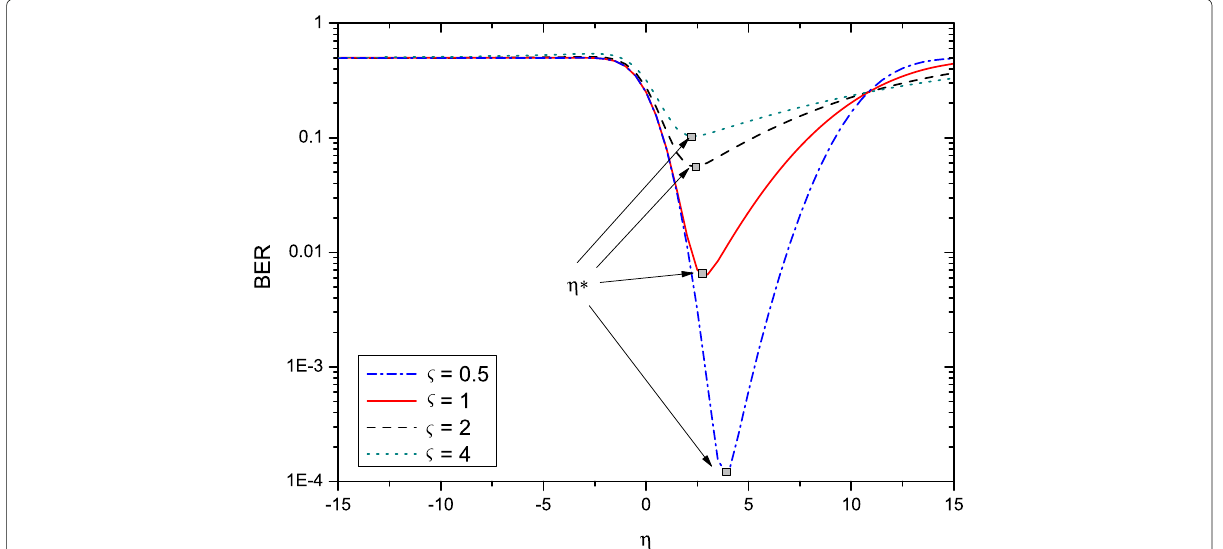
Fig. 3 The value of BER versus η with different ς when r = 0.9, ( a , b , c ) = ( 2 m,2 m,1.5 m ) , ( u , v , w ) = ( 2.5 m,2.5 m,3 m ) , P = 55 dBm and σ =